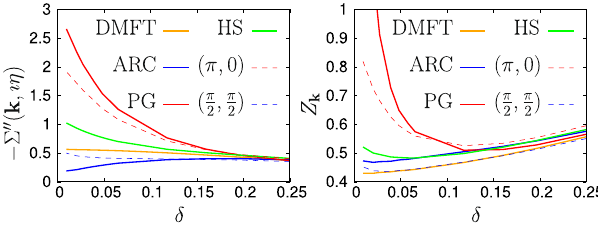
Fig. 6 Scattering rate − Σ ″ (k, ı η ) and quasiparticle weight Z k versus hole doping δ at indicated points in the Brillouin zone. Both quantities are obtained through polynomial extrapolation to the Fermi level, η = 0 +